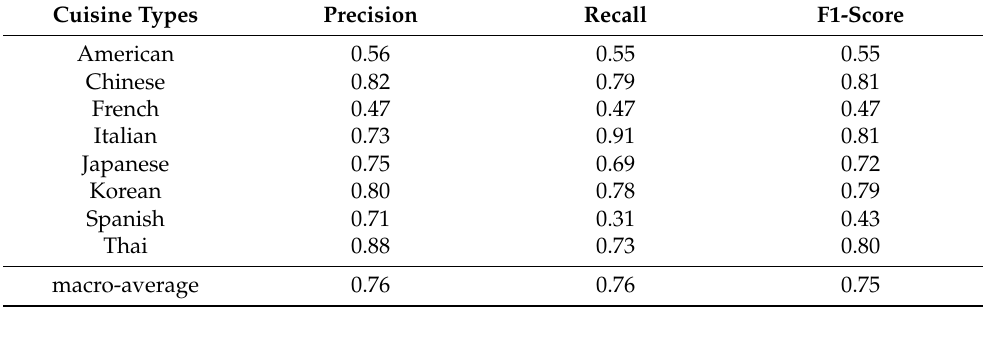
Figure 5. Confusion matrix of SVM classifier. Table 5. Performance of the naïve Bayes classifier.